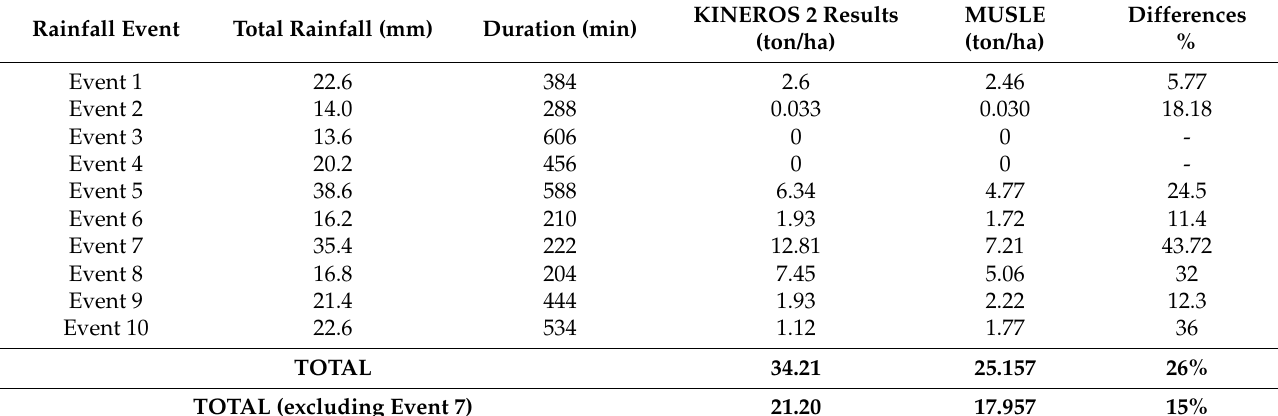
Table 4. Differences between calculated results using MUSLE and KINEROS 2